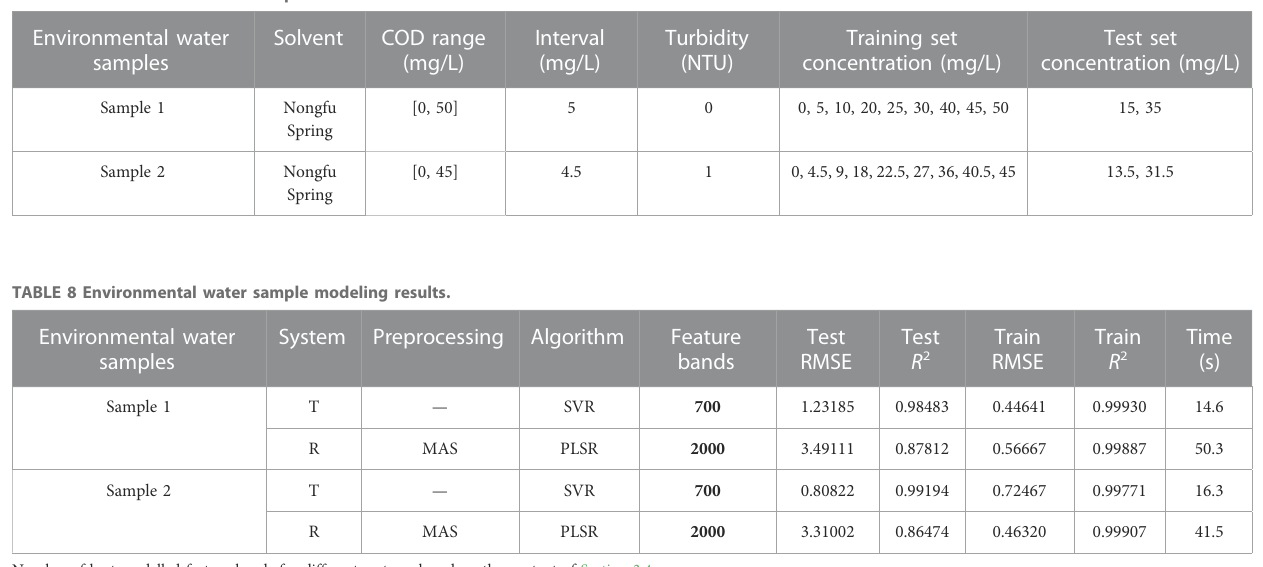
TABLE 7 Environmental water sample concentrations and divisions.